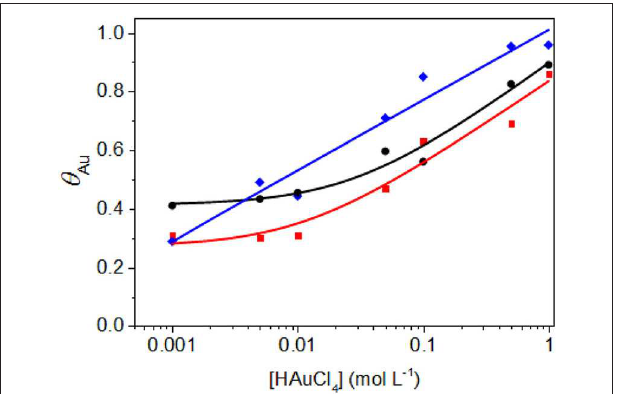
FIGURE 3 | Plot of the Au coverage ( θ Au ) after dipping in HAuCl 4 solution at T = 293K as a function of the HAuCl 4 concentration. – for Pd-NS, – for Pd-NC and – for